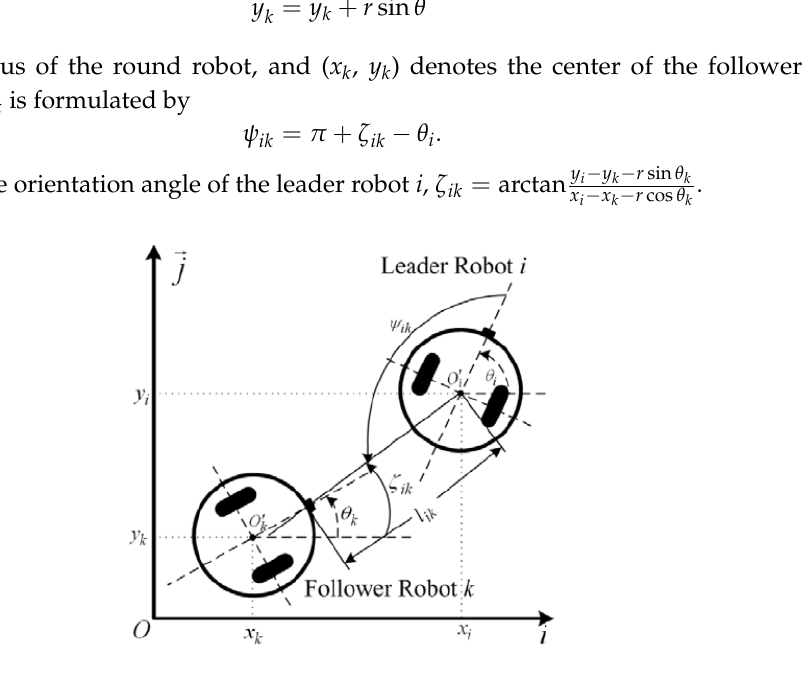
Figure 2. Sketches of the leader–follower coordinated framework.